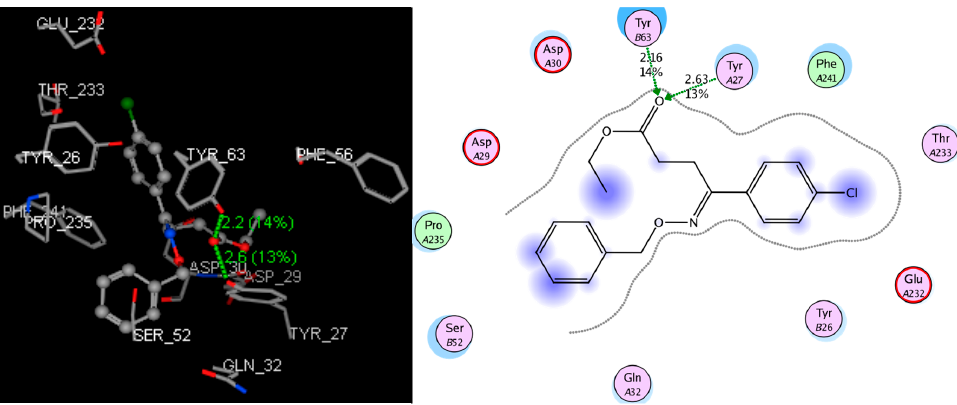
Figure 2. Binding mode of compound 3c-2 with 3OX8. The hydrogen bond formed is colored in green.